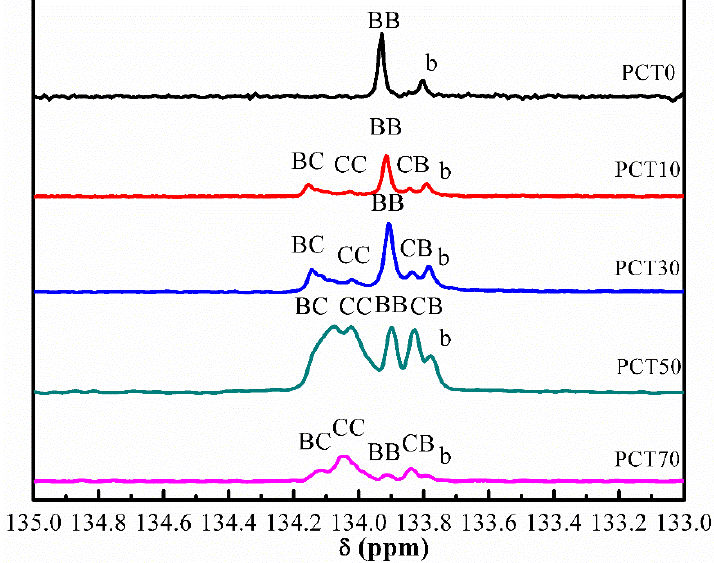
Figure 4. 13 C NMR spectra of the (PBT-co-PCT)-b-PTMG copolymers.